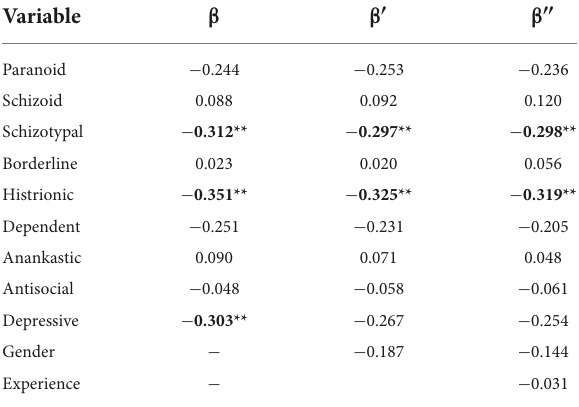
TABLE 4 Combined regression model, β (cid:48) : controlling for gender, β (cid:48)(cid:48) controlling for gender and game experience.